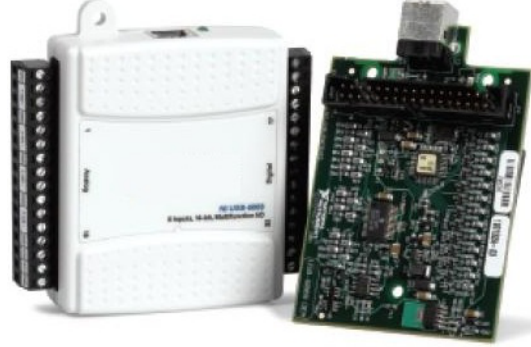
Figure 3. The selected National Instruments (NI) acquisition card.